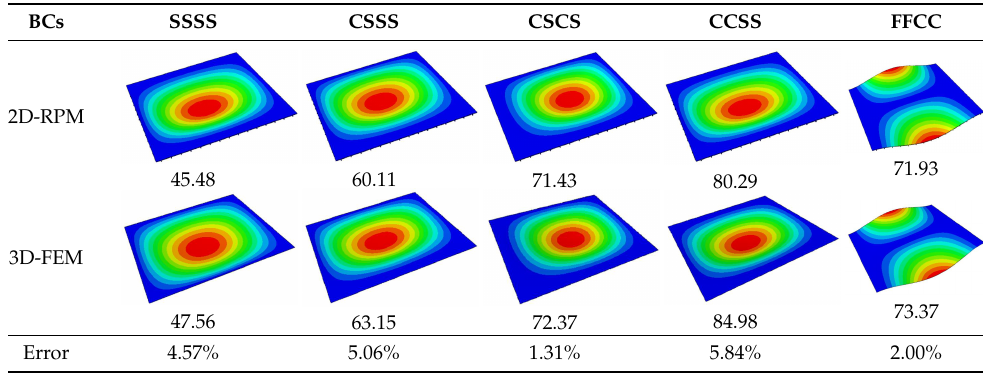
Table 2. Comparison of vibration modes and natural frequencies (Hz) of the OSFP under different boundary conditions